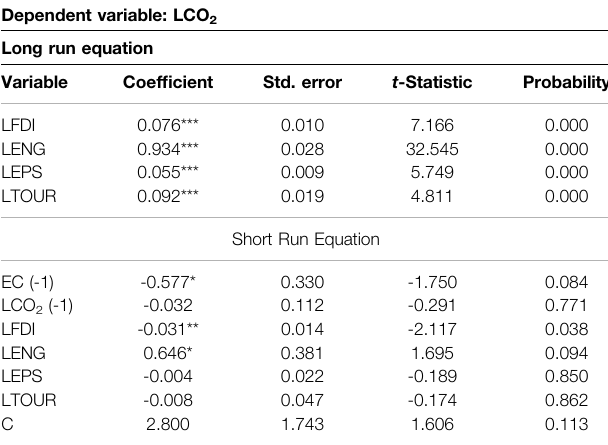
TABLE 6 | Estimates of